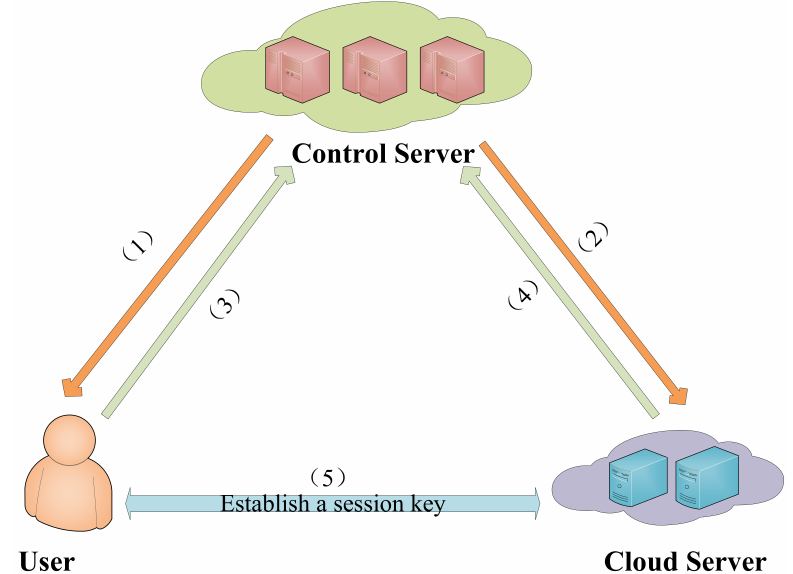
Figure 2. Information exchange process.